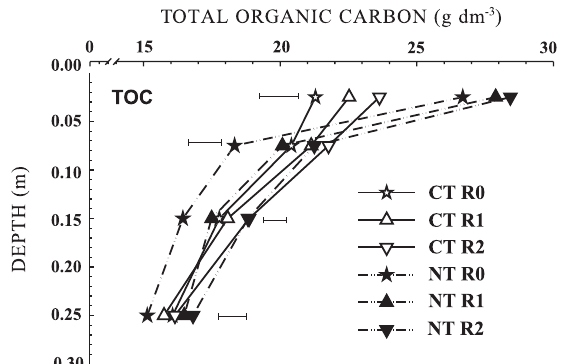
Figure 2. Contents of total organic carbon (TOC) in subtropical Oxisol under conventional tillage (CT) and no tillage (NT) systems under three cropping systems (R0=wheat/soybean, R1=wheat/soybean/black oat/soybean, R2=black oat/soybean/ black oat+common vetch/maize/ oilseed radish/wheat/soybean). Horizontal bars represent the LSD by t test at 5% probability.